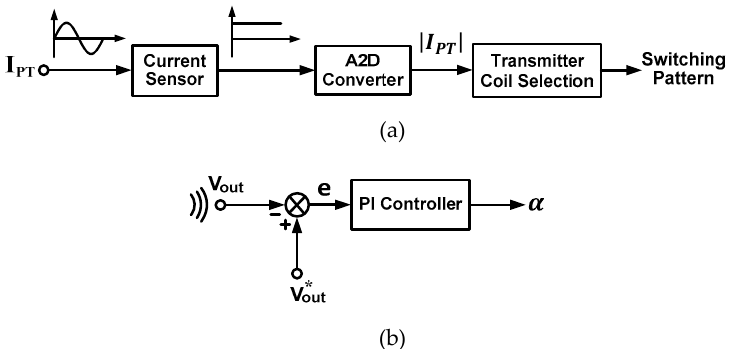
Figure 14. Proposed control block diagram of the primary-side controller: ( a ) Transmitter coil pattern selection mode; ( b ) Output voltage regulation mode.